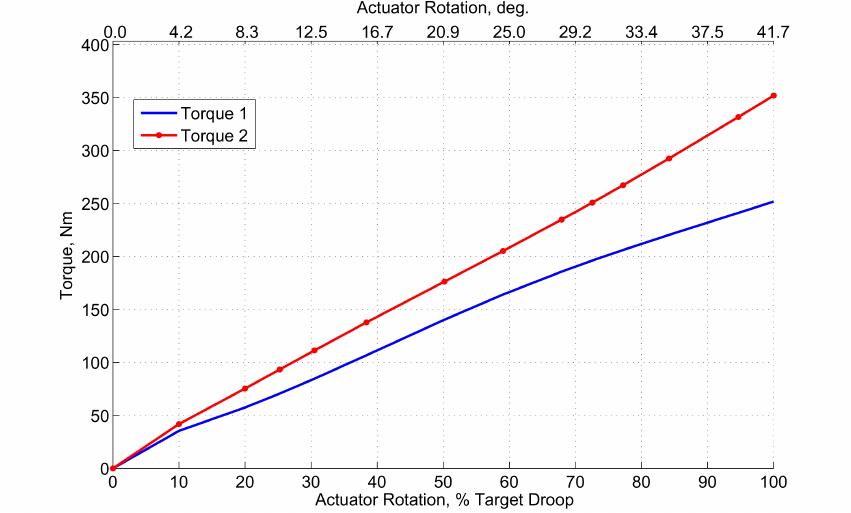
Figure 14. Finite element results of actuator torque without aerodynamic